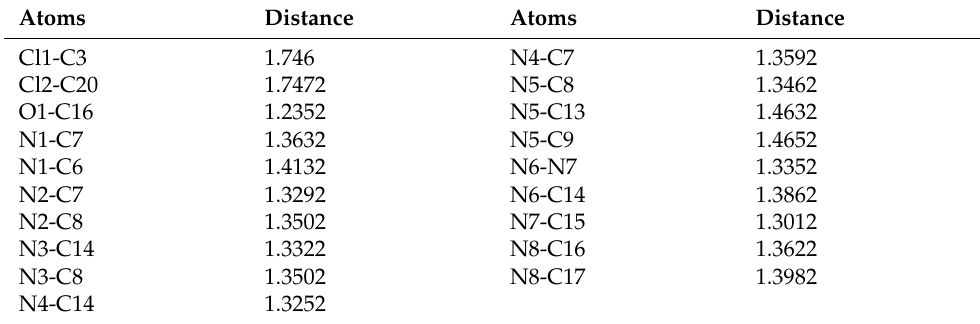
Figure 1. X-ray structure of 6c . Figure 1. X-Ray structure of 6c . Table 2. Selected bond lengths [Å] for 6c a Table 2. Selected bond lengths [Å] for 6c a .